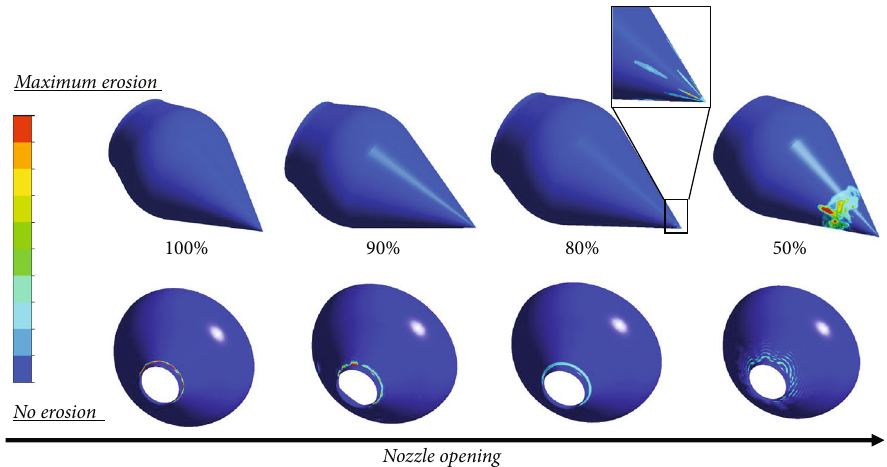
Figure 15: Needle and nozzle erosion upon various nozzle opening.